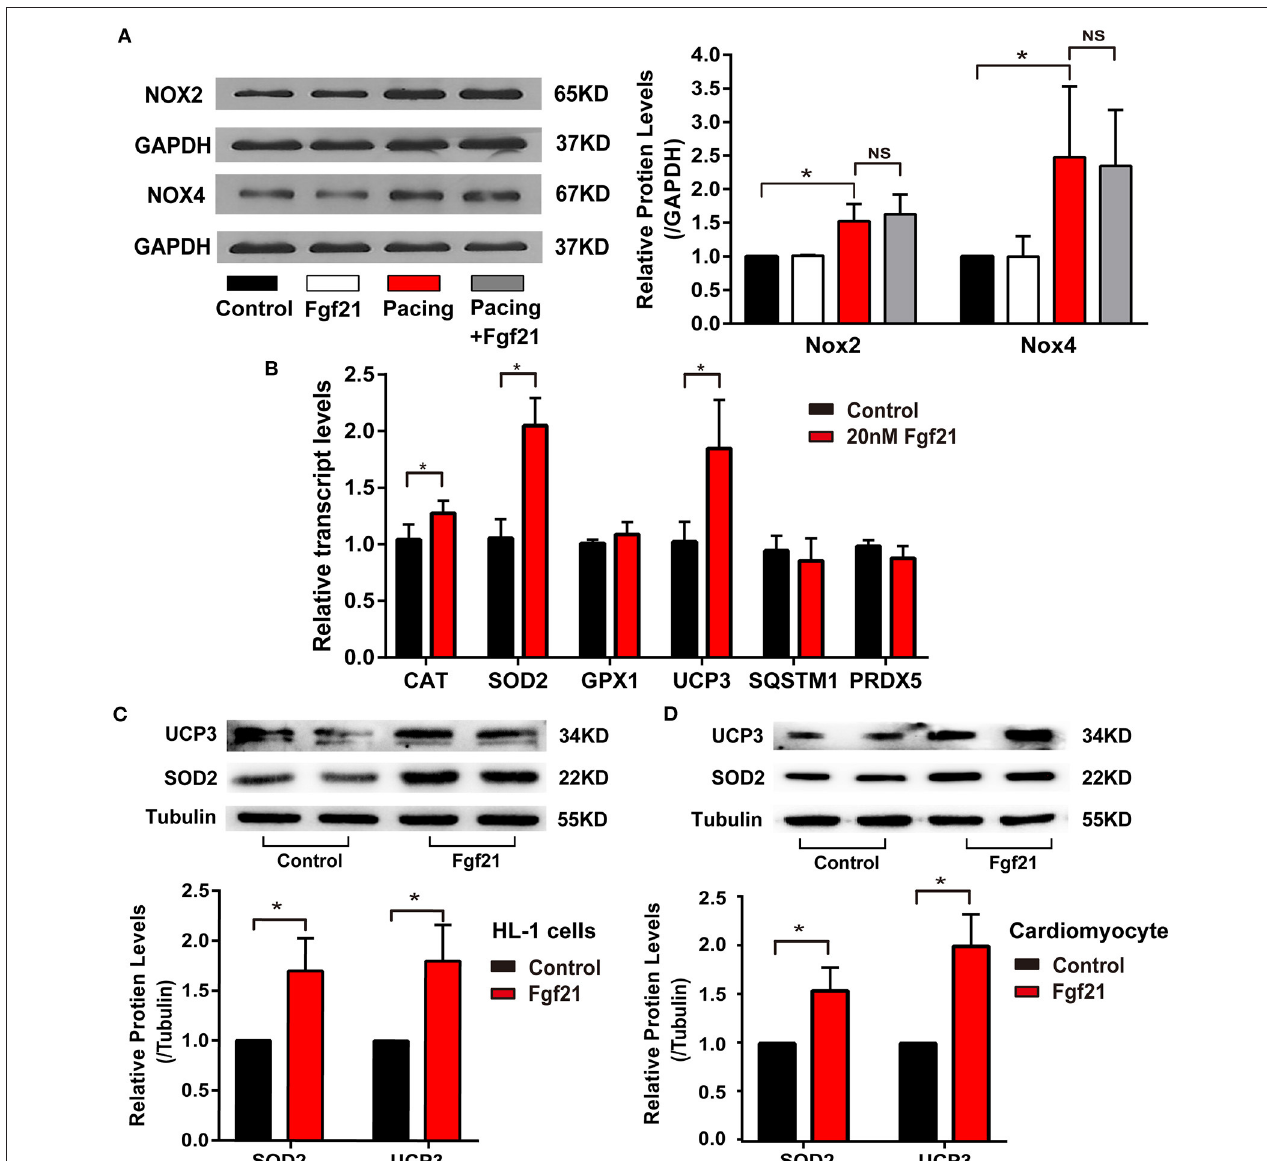
FIGURE 6 | Fgf21 induces anti-oxidative gene expression. (A) The expression of Nox2 and Nox4 at protein levels in each group of HL-1 atrial cells. (B) The expression of various anti-oxidative genes at mRNA levels in HL-1 after being treated with 20nM Fgf21. (C) The expression of SOD2 and UCP3 at protein levels in HL-1 cells after being treated with 20nM Fgf21. (D) The expression of SOD2 and UCP3 at protein levels in primary cardiomyocytes after being treated with 20nM Fgf21. * p < 0.05; ns, none